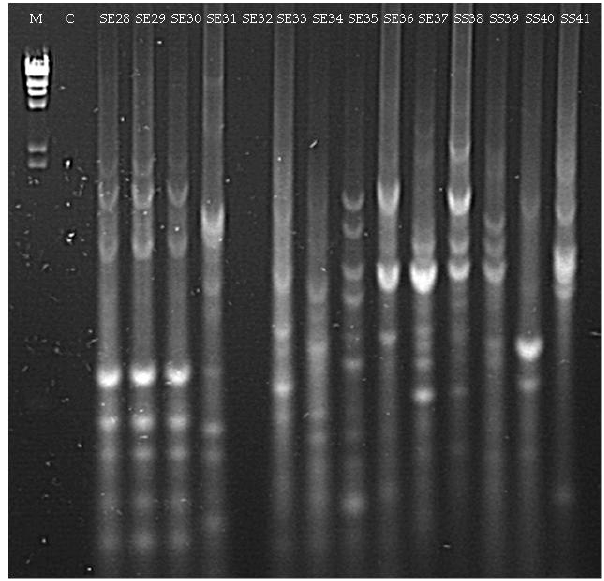
Figure A4. BOX-PCR profiles of isolated obtained from Elpida and Silverio seedlings, were checked by electrophoresis in 1.5% agarose gels stained with ethidium bromide that included a marker Lambda/ Hind III.